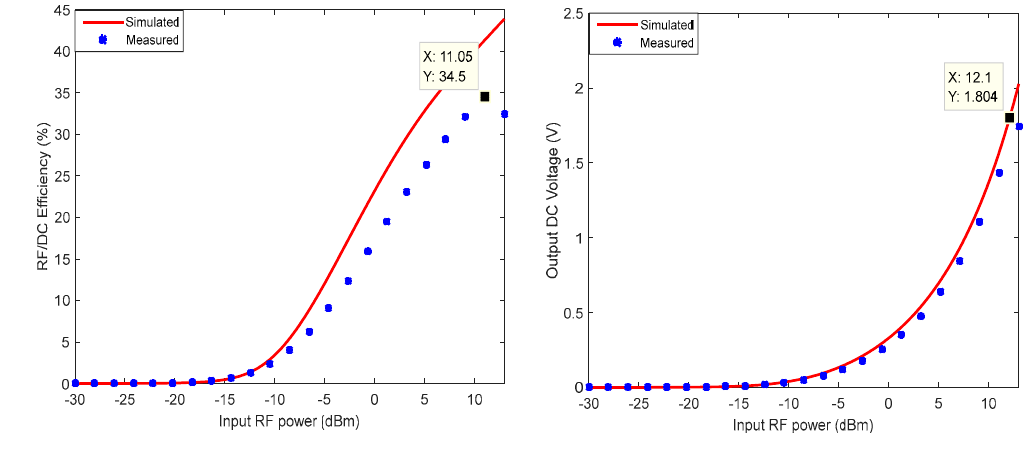
Figure 17. Rectifier measurements results.